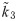
Comparison of stochastic simulation and Fokker-Planck-Equation.Stationary distributions obtained by stochastic simulation (histograms) and by solving the Fokker-Planck-Equation (lines) for different values of k˜3 (other parameters: k˜1=8·106,k˜2=1.33·105, see the gray line in Fig 1). The dark dots indicate the fixed points of the deterministic model.